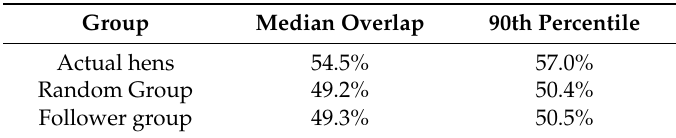
Table 3. Median and 90th percentile of time that hen pairs spent together (both inside and outside).